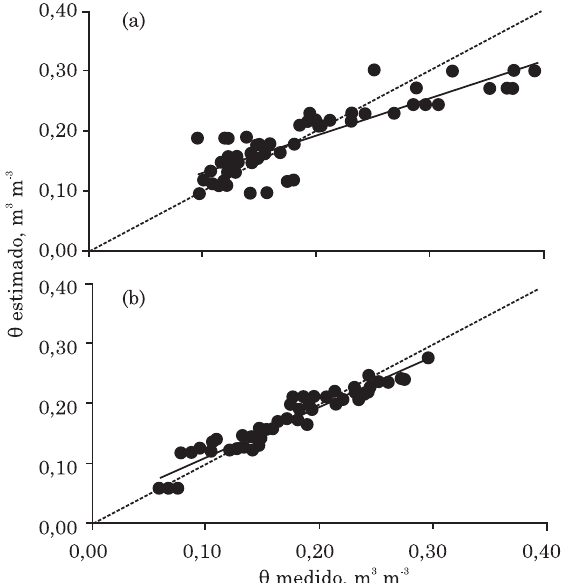
Figura 3. Equação de regressão entre o conteúdo de água estimado (  estimado) e medido (  medido) nas estratégias USUAL (a) e CAMPO (b). A linha tracejada corresponde à relação